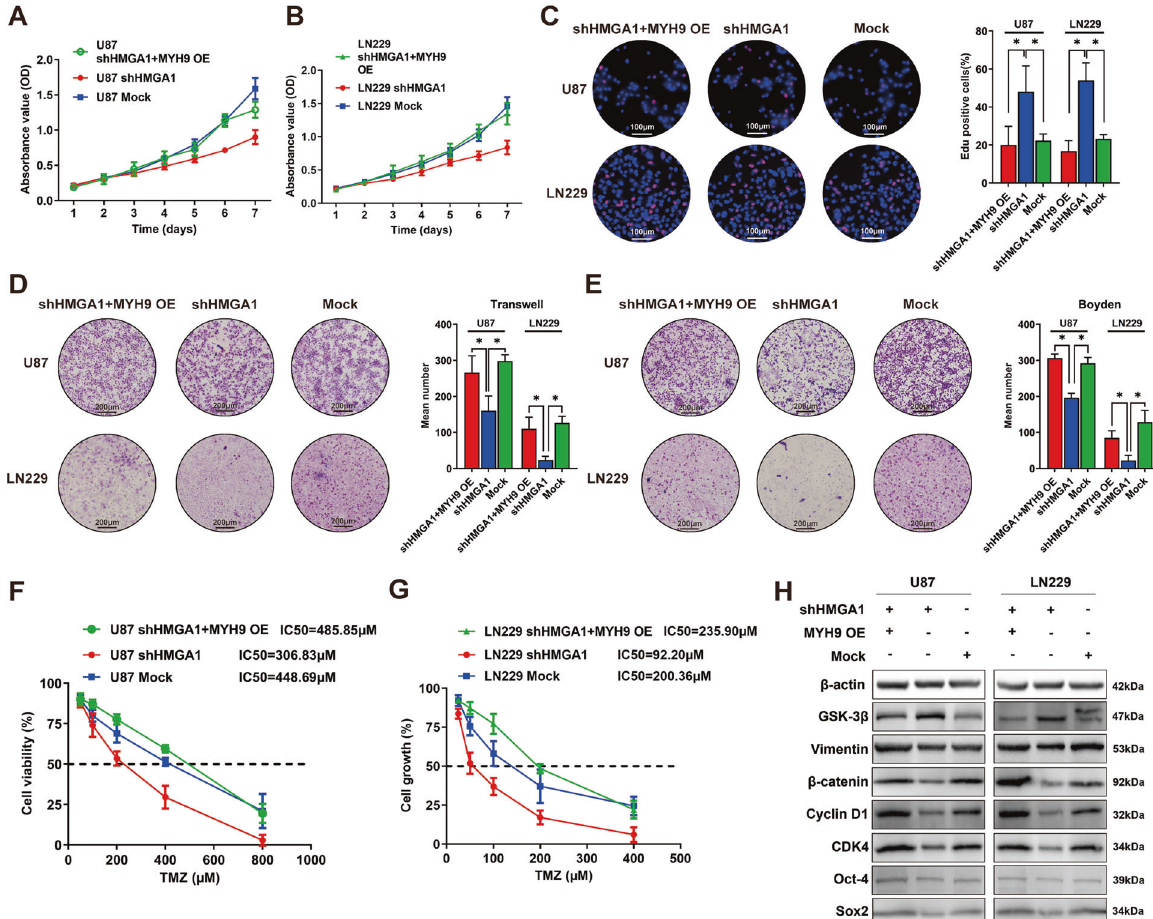
Boyden ( E ) chamber assays veri fi ed that the ability of cell invasion and migration was recovered in shHMGA1 + MYH9 plasmid-treated cells group compared to shHMGA1-treated cells group. F , G Dose – response curves for TMZ showed the TMZ concentration causing IC 50 was rescued in shHMGA1 + MYH9 plasmid-treated cells groups compared to shHMGA1-treated cells groups. H Western blot assay con fi rmed MYH9 upregulation rescued shHMGA1-mediated reduction of the EMT-related proteins, the cell cycle-related factors, and the stemness-related factors, and MYH9-overexpression could reverse the shHMGA1-mediated increase of GSK-3 β